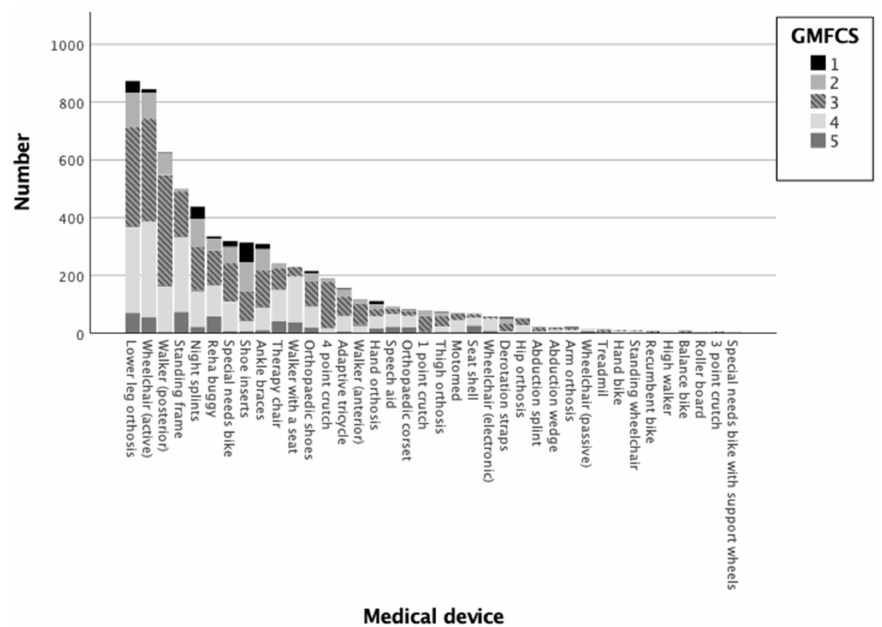
Figure A1. Distribution of medical devices by GMFCS-level: Bar chart of the number of different medical devices divided by GMFCS-level in descending order.